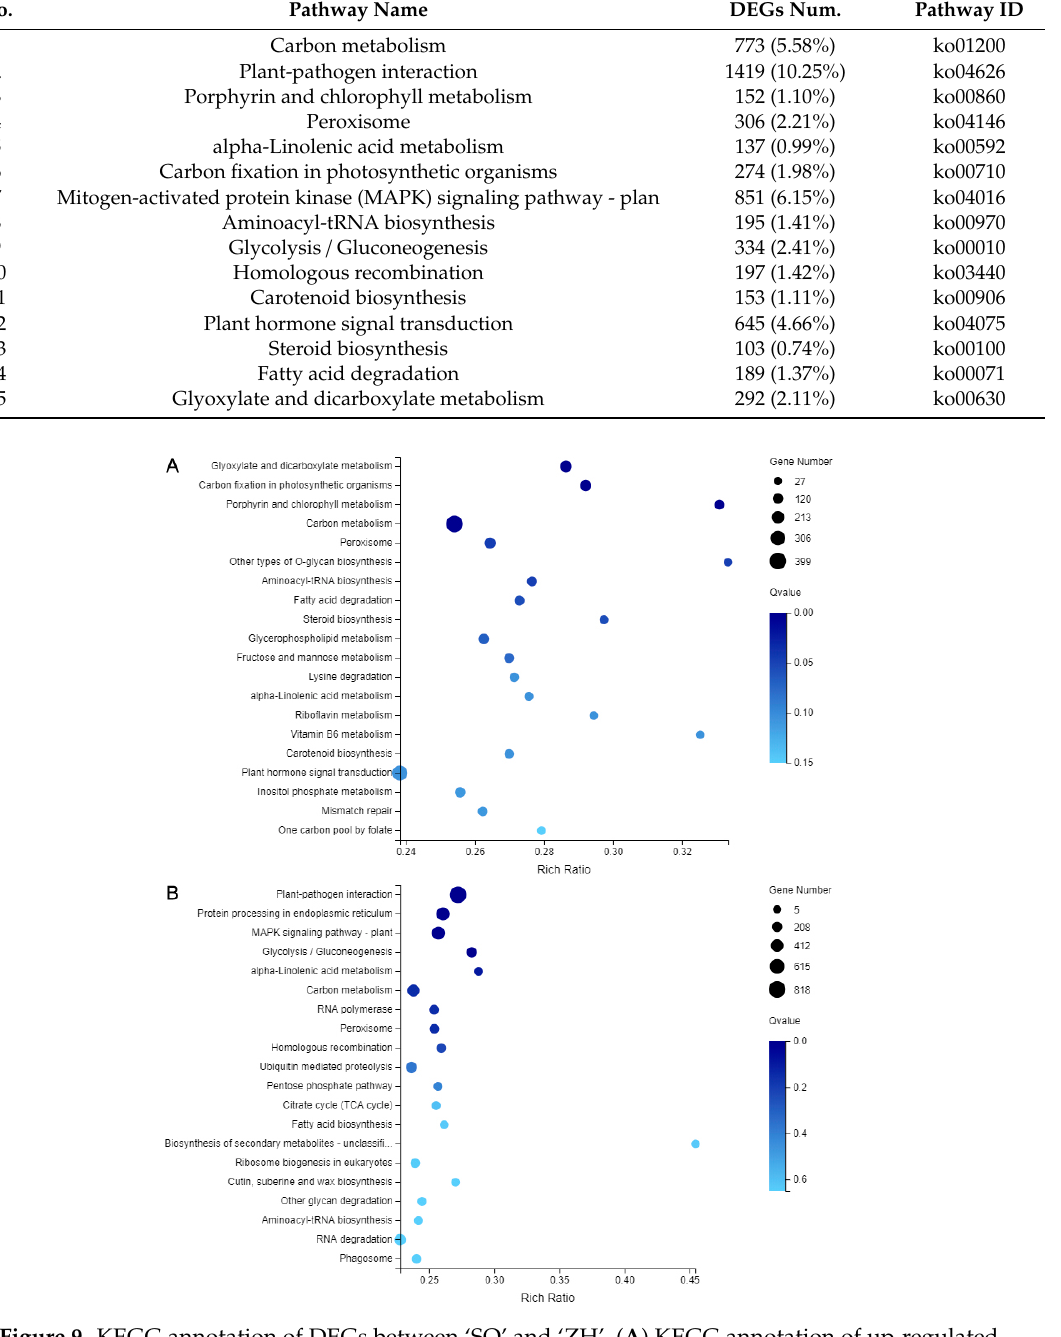
Figure 9. KEGG annotation of DEGs between ‘SO’ and ‘ZH’. ( A ) KEGG annotation of up-regulated DEGs; ( B ) KEGG annotation of down-regulated